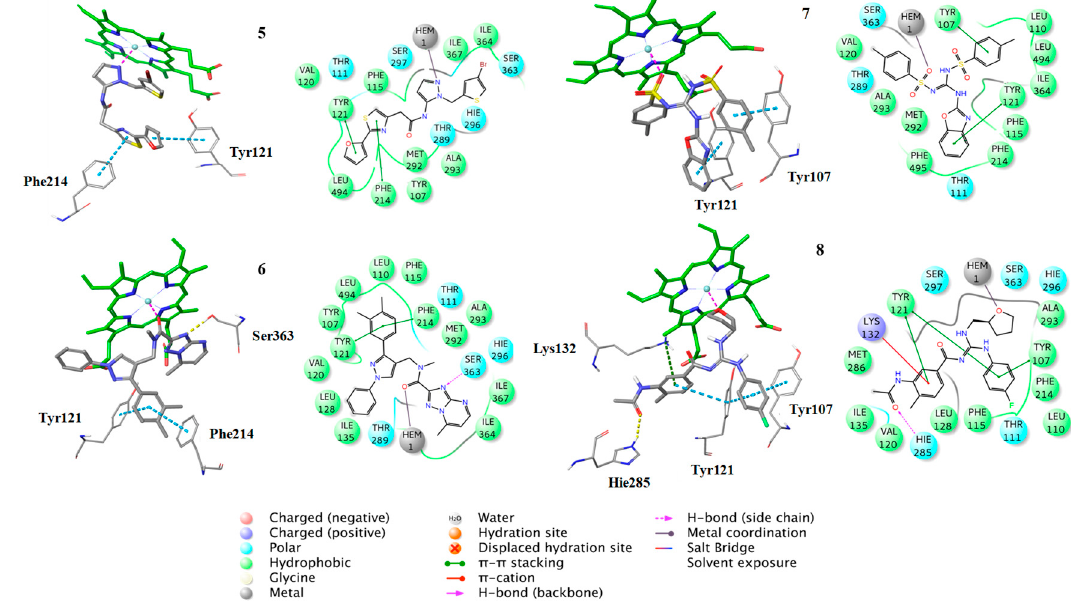
Figure 8. Binding poses of the compounds 5–8 , with the corresponding 2D ligand interaction diagrams, derived from molecular docking studies. Hie is the deprotonated His.